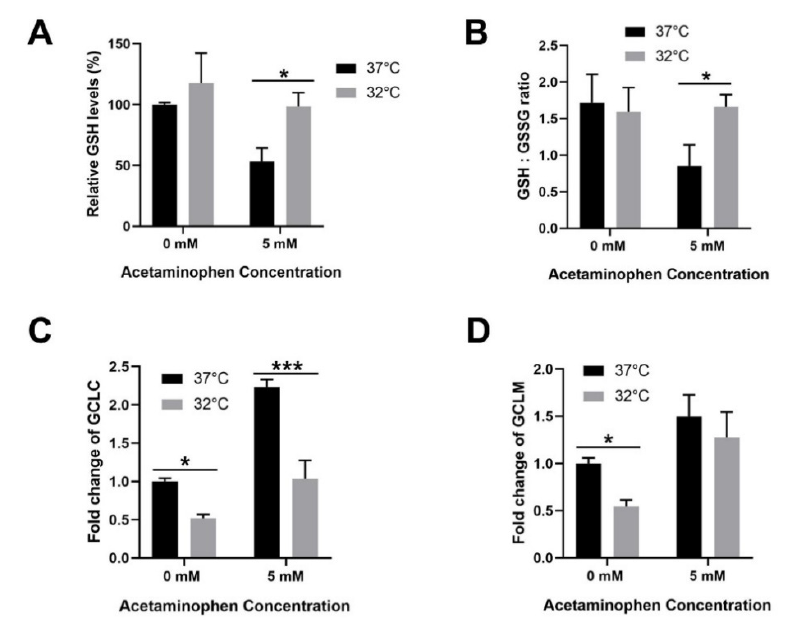
Figure 4. Effect of moderate hypothermia (32 °C) on glutathione homeostasis in TAMH. ( A ) Relative glutathione (GSH) levels and ( B ) GSH / oxidized glutathione (GSSG) ratio were determined to examine GSH changes and the flux of GSH recycling. Quantitative analysis with real time RT-PCR was also performed to determine the transcript expressions of ( C ) glutamate-cysteine ligase, catalytic subunit (GCLC) and ( D ) glutamate-cysteine ligase, modifier subunit (GCLM), which assembles to form the rate-limiting enzyme, glutamate cysteine ligase, in the glutathione biosynthesis. β -actin was used as the housekeeping gene. Data are presented as mean ± SD ( n = 3), where unpaired t -test was used to compare the effect of hypothermia on TAMH against their respective controls treated with the same APAP dose. * p < 0.05, *** p < 0.001.